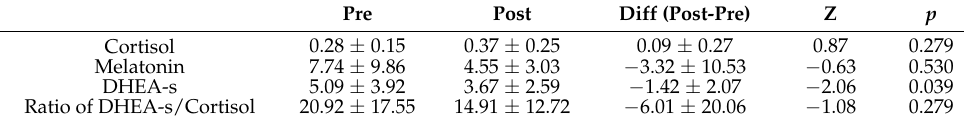
Table 4. Changes of the physiological variables of the participants (N = 13).